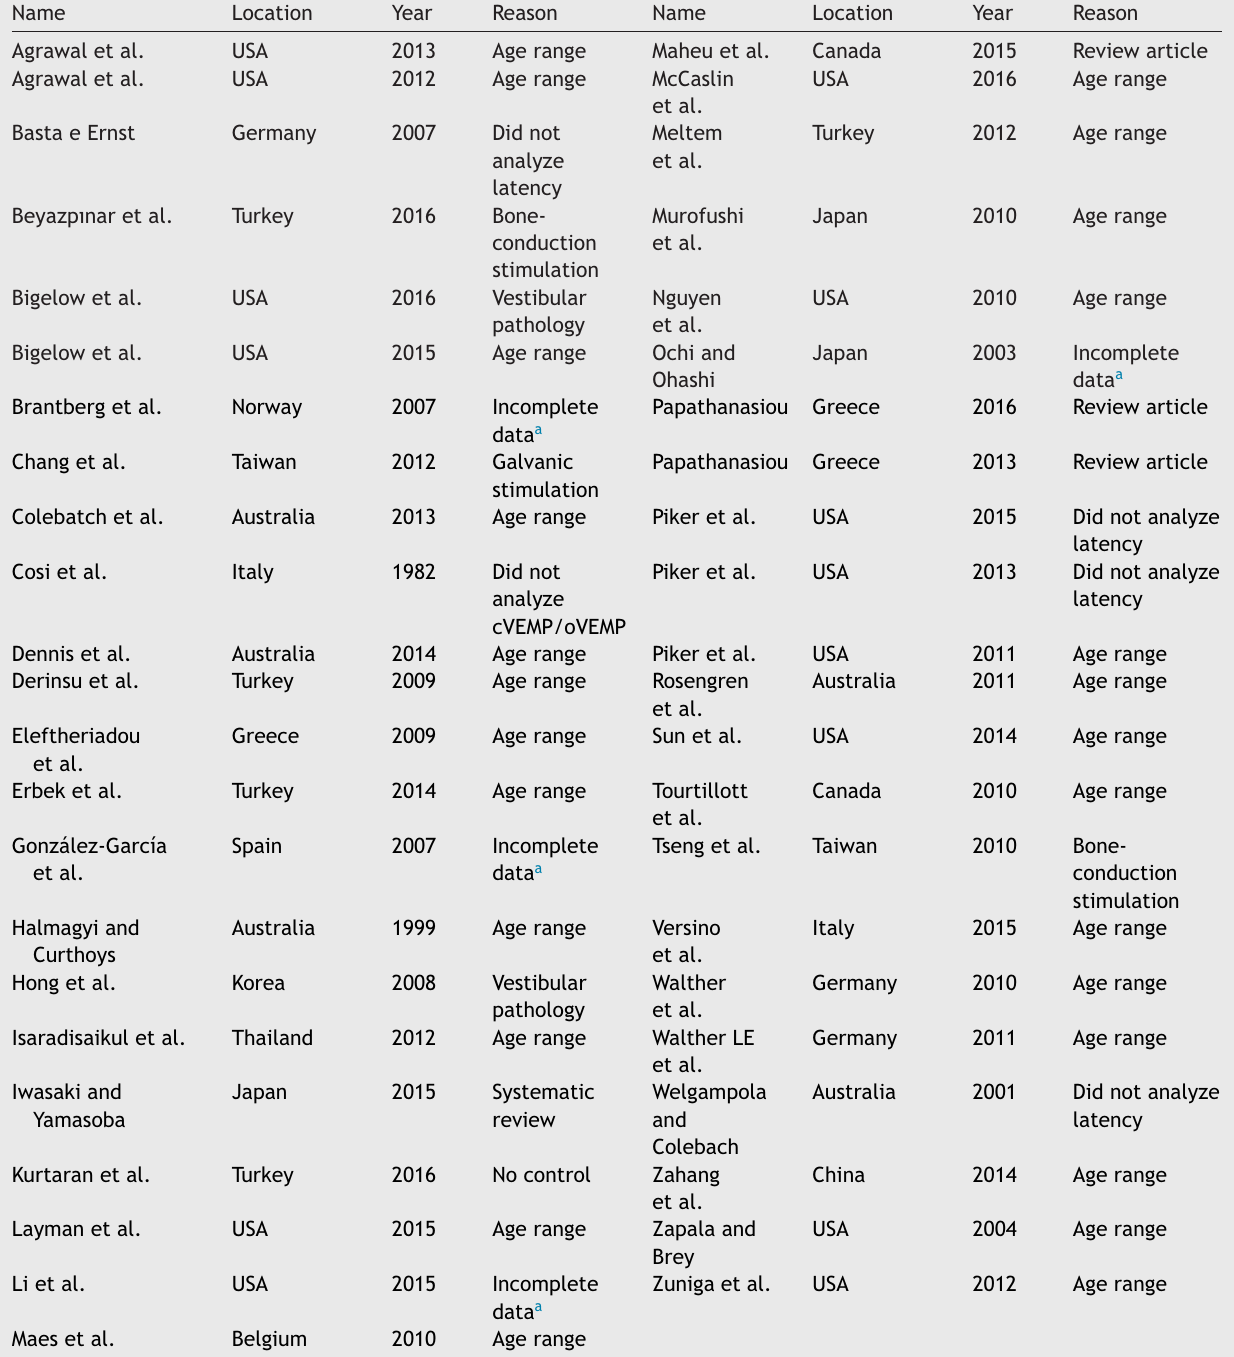
Full texts excluded from the